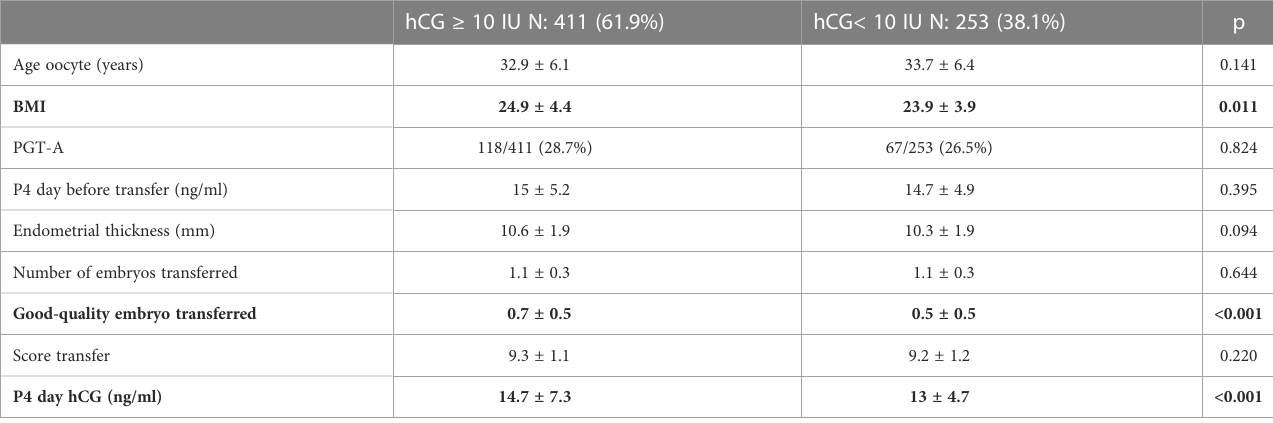
TABLE 2 Baseline characteristics between hCG positive (hCG ≥ 10 IU) and. hCG negative (hCG < 10 IU).